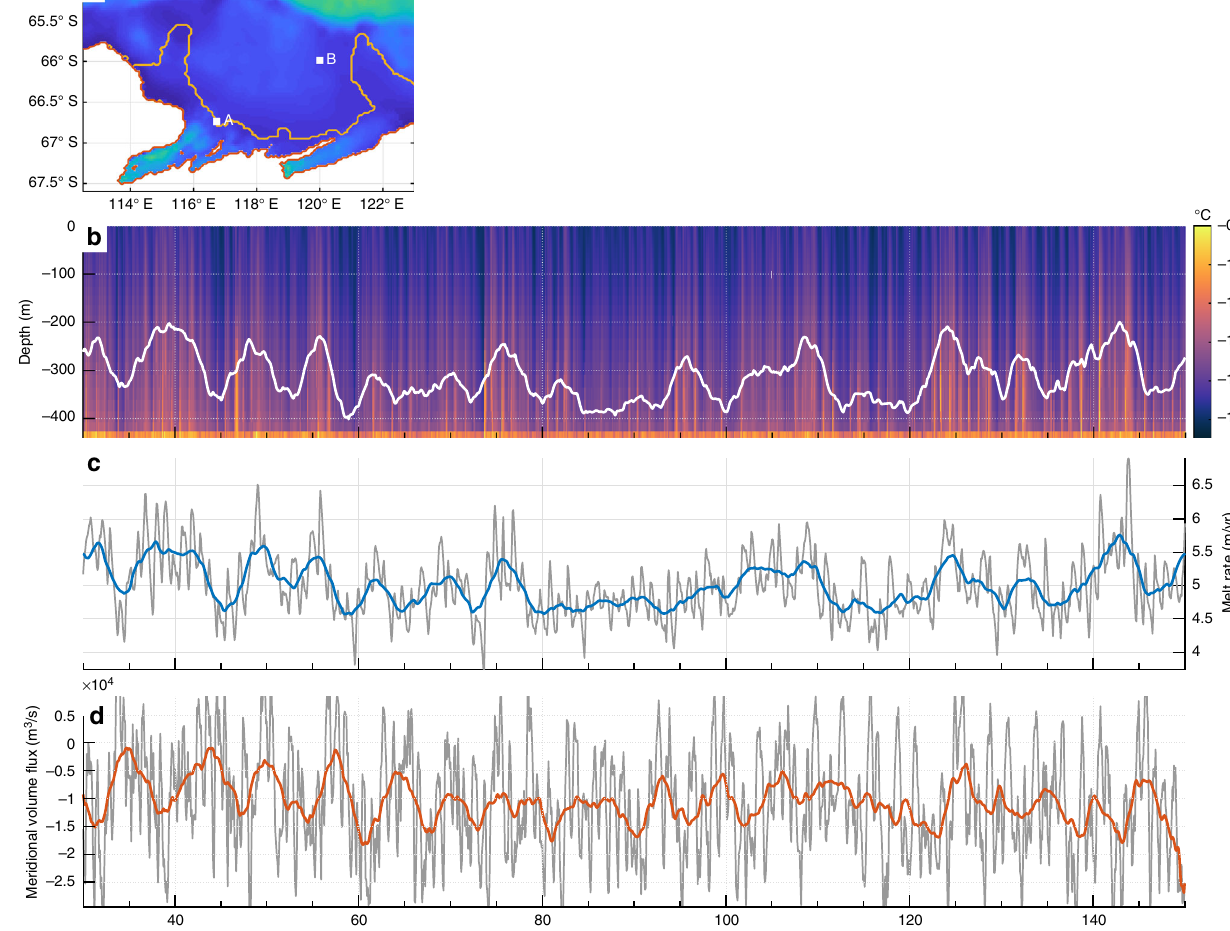
Fig. 2 Intrinsic variability in MCDW thickness and cross-shelf exchange. a Intrinsic variability in ocean properties are shown at the ice front (A; 116.7° E, 66.7° S) and near the shelf break (B; 120° E, 66.0° S). b Potential temperature at the ice front, location marked as A, with the smoothed − 1.5 °C temperature anomaly contour, representing the thickness of the bottom MCDW layer, shown in white. c Area-averaged melt rate for the TIS shown raw (grey line) and smoothed (blue line), and correlates well with MCDW thickness. d Meridional volume fl ux integrated over depth, with raw monthly averages (grey line) and smoothed (orange line) values. Negative values represent southward integrated transport, and hence transport onto